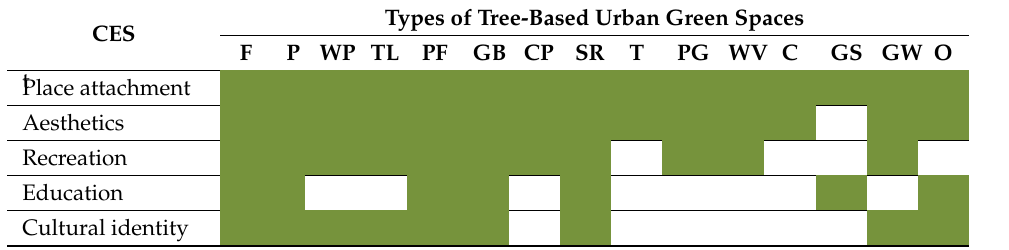
Table 7. Perceived cultural ecosystem services (CES) by various types of tree-based urban green spaces (UGSs). Green indicates the assignation of CES to particular type of UGS. (F—forest,